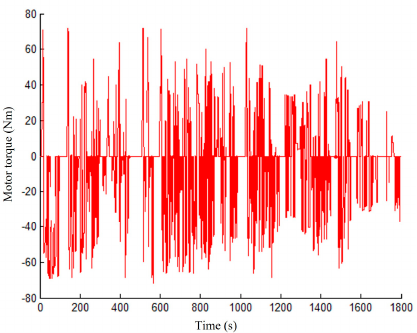
Figure 9. Engine load corresponding to different power systems under NEDC test conditions.